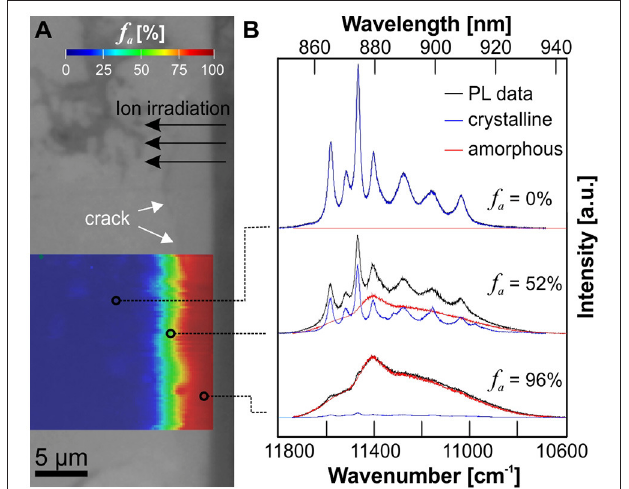
FIGURE 4 | (A) Optical micrograph image of a cross-sectioned LaPO 4 ceramic (e1, irradiated with 1.5 × 10 13 ions/cm 2 ) superimposed by a PL hyperspectral map with the amorphous fraction f a given color-coded. (B) Representative PL spectra of the Nd 3 + emission ( 4 F 3 / 2 → 4 I 9 / 2 ) obtained from various depths below the irradiated surface illustrating the deconvolution procedure used to determine f a from PL data. The red component represents a spectrum of the very same Nd 3 + emission from a completely amorphized reference sample. Note, that the lowest irradiation fluence applied in this study was sufficient to produce an almost completely amorphized surface layer in LaPO 4 .